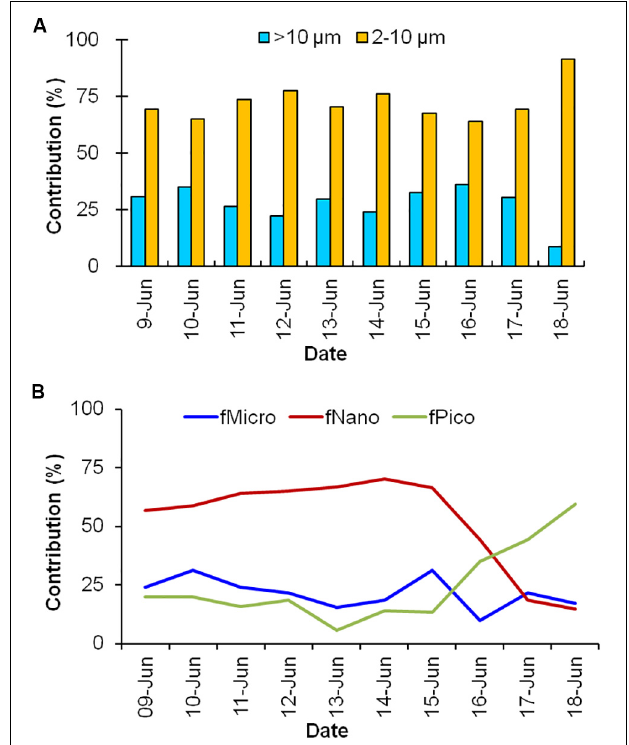
FIGURE 4 | Size-fractionated contribution (%) of phytoplankton community structure measured by (A) fluorometric and (B) HPLC-based pigment analysis in the surface layer of the TS